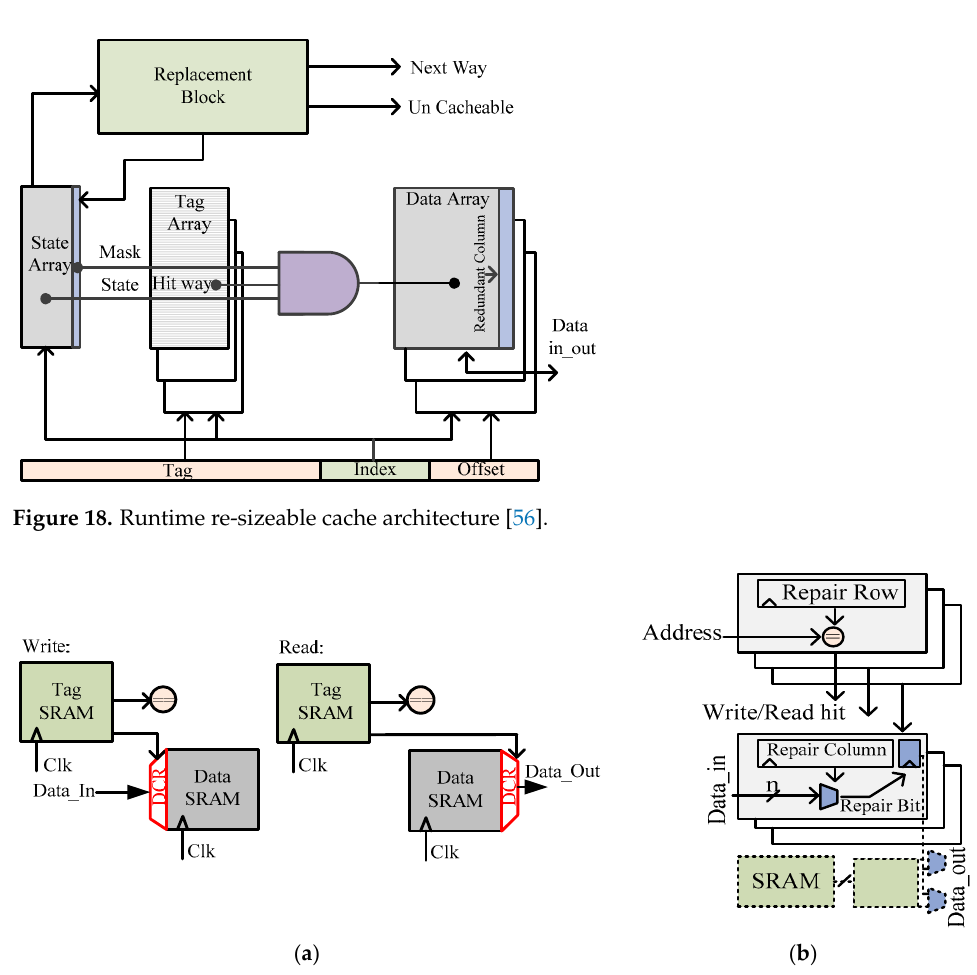
Figure 18. Runtime re-sizeable cache architecture [56].